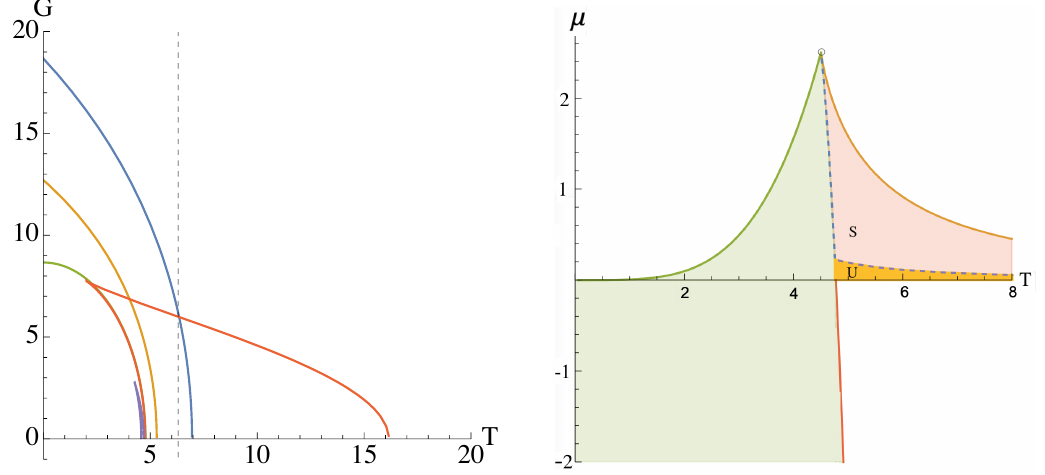
˜ Q, V , µ ) ensemble 0 < T < T 1 , the high-entropy 1